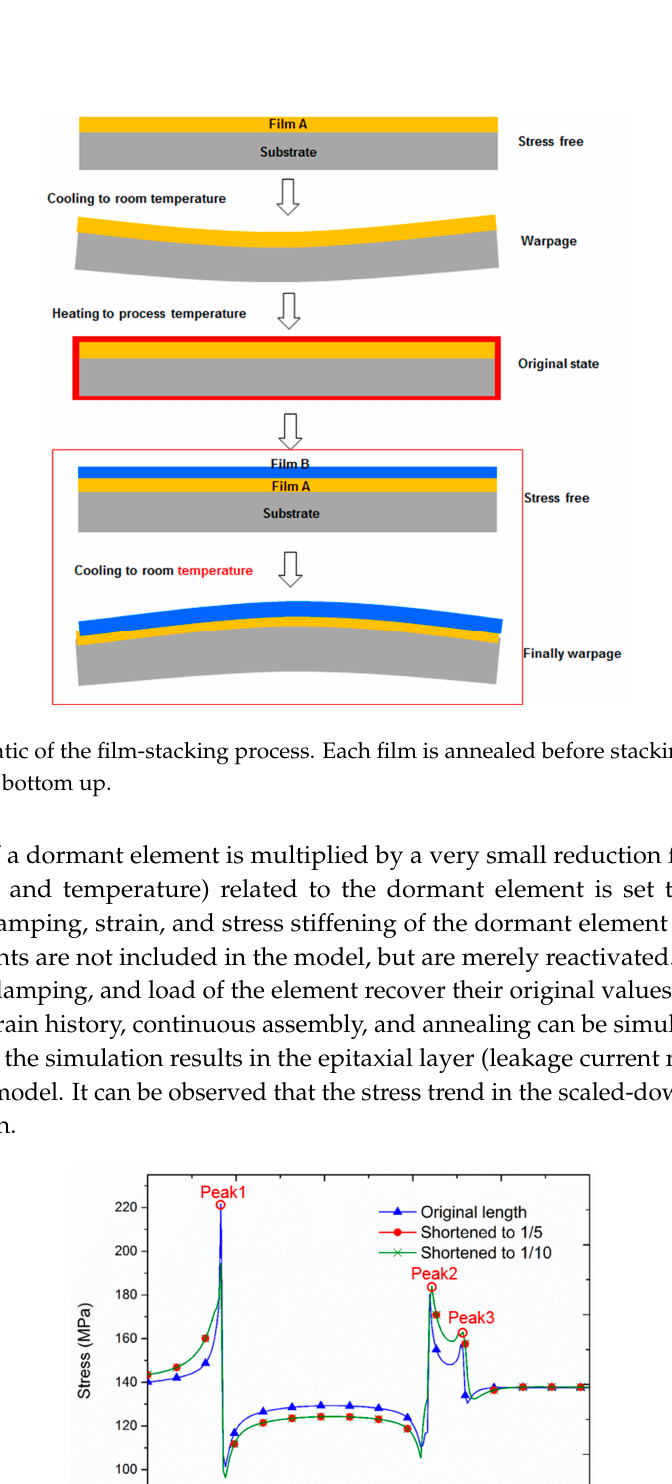
Figure 5. Stress distribution in the BLC area computed by the scaled down model.